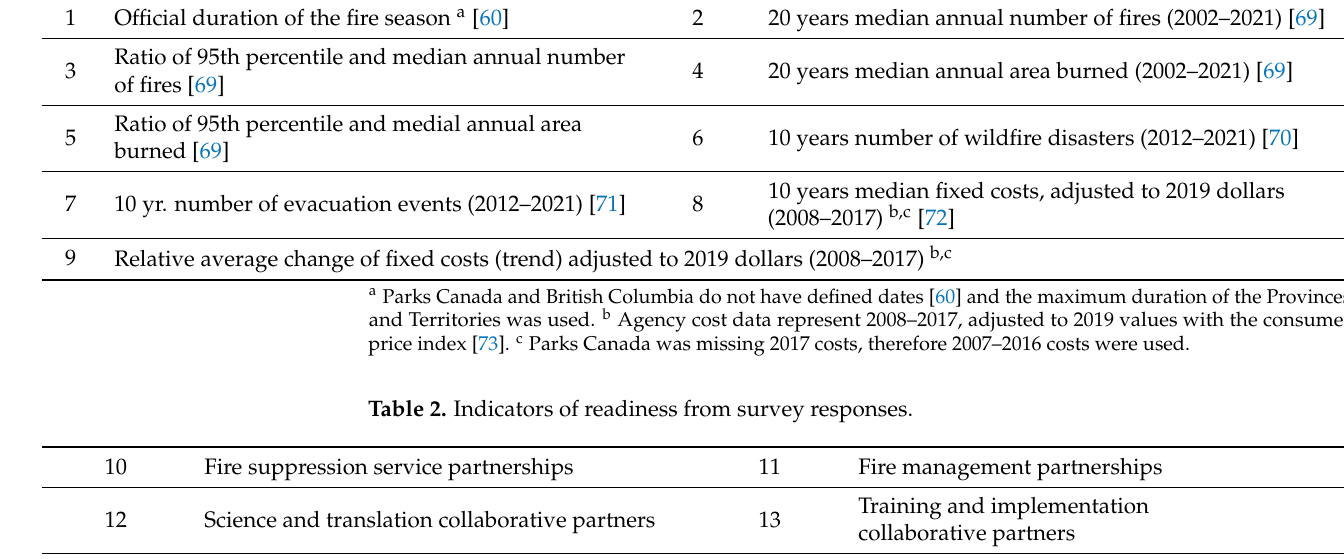
Table 1. Quantitative indicators of readiness from available datasets on agency workload and activities.